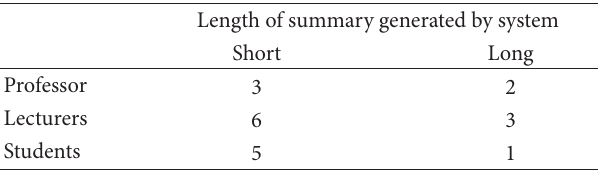
Table 5: Comparison of length of summary generated by human and